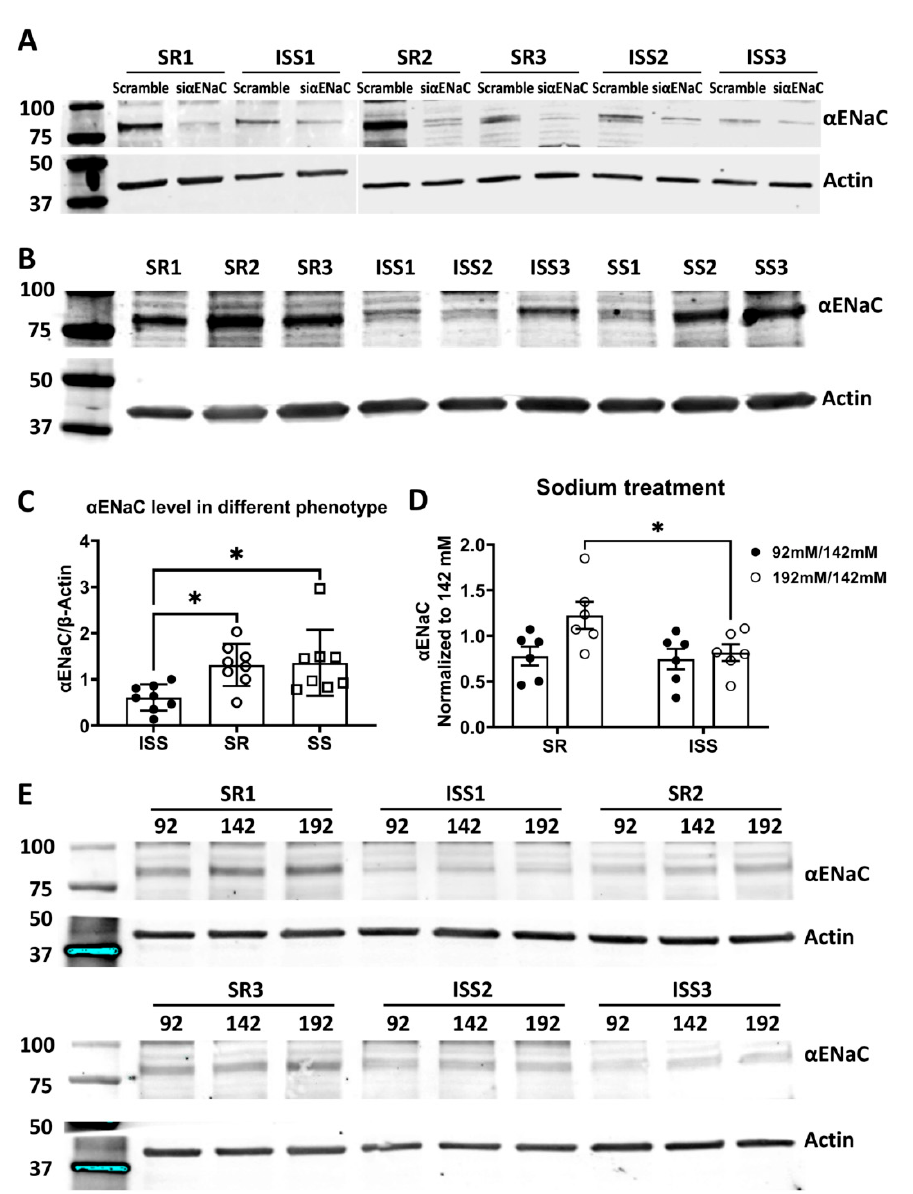
Figure 4. α ENaC in urine-derived renal tubule cells by Western blot. ( A ) α ENaC siRNA was used to knock down α ENaC to confirm that α ENaC is about 85 kDa. Scrambled RNA was used as control. ( B , C ) Representative α ENaC Western blot in urine-derived hRTCs (0.61 ± 0.1; SR 1.31 ± 0.16; SS 1.36 ± 0.25; n = 8/group, ISS vs. SR, ISS vs. SS, * p < 0.05, one-way ANOVA, Tukey’s post hoc test, normalized by β -actin, then by SR1). ( D , E ) Sodium treatment in SR and ISS CD13+ renal tubule cells. The ratio of high sodium over normal sodium is significantly lower in ISS than SR (192 mM/142 mM: SR, 1.22 ± 0.15 vs. ISS, 0.82 ± 0.09, two-way ANOVA, Sidak’s post hoc, * p < 0.05; 92 mM/142 mM: SR, 0.78 ± 0.10; ISS 0.74 ± 0.11, n = 6/group). β -actin was used as loading control in all western blot